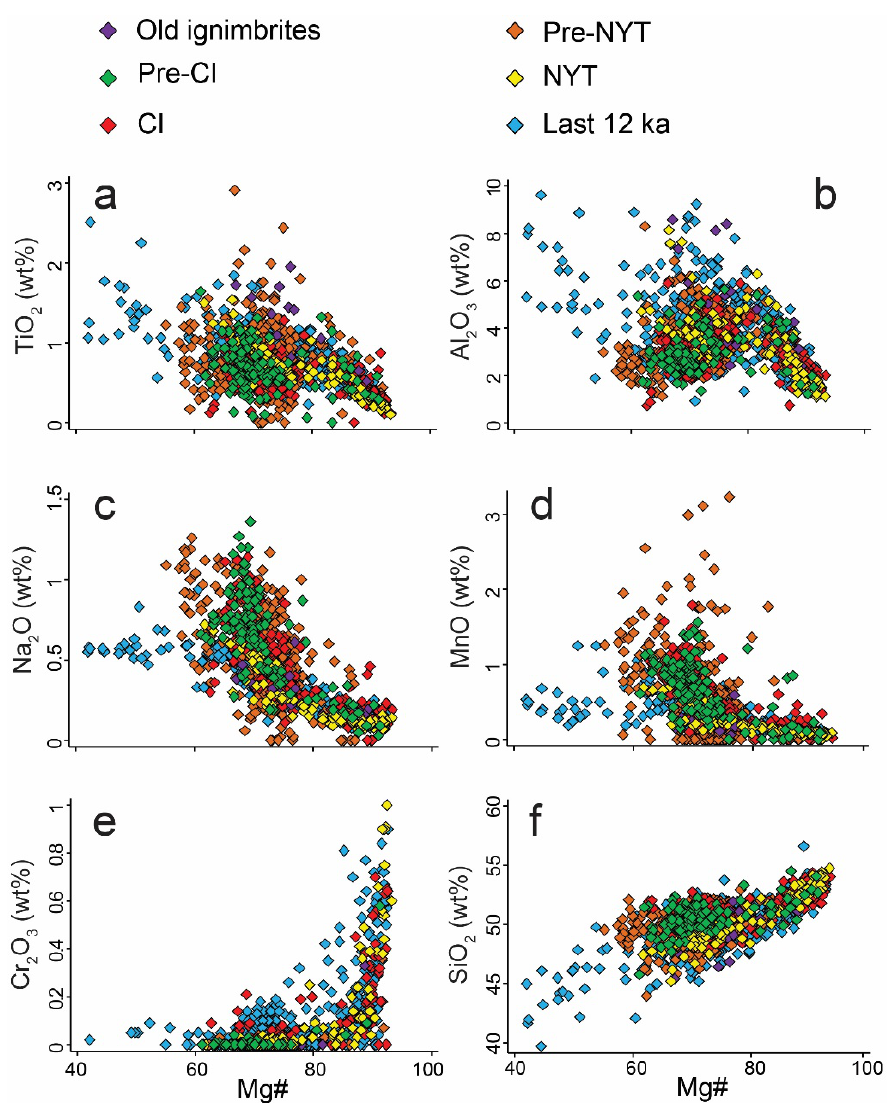
Figure 5. ( a ) Mg# vs TiO 2 , ( b ) Mg# vs Al 2 O 3 , ( c ) Mg# vs Na 2 O, ( d ) Mg# vs MnO, ( e ) Mg# vs. Cr 2 O 3 , and ( f ) Mg# vs SiO 2 of clinopyroxene crystals from volcanic products belonging to different periods of Campi Flegrei’s activity.